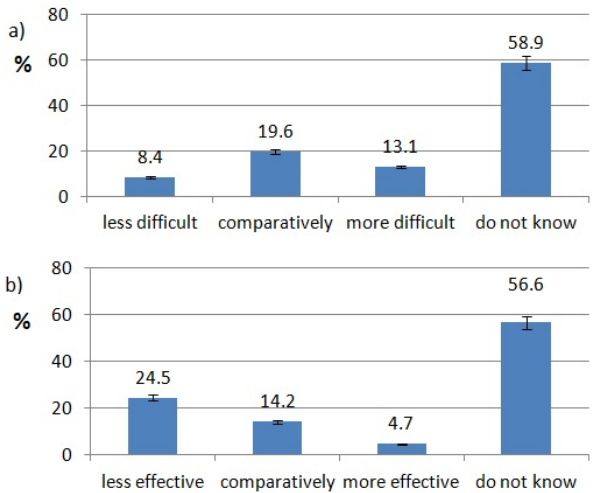
Figure 7. Chemo-mechanical caries removal use pattern of responding dentists; ( a ) effectiveness of CMCR, ( b ) difficulty of CMCR.